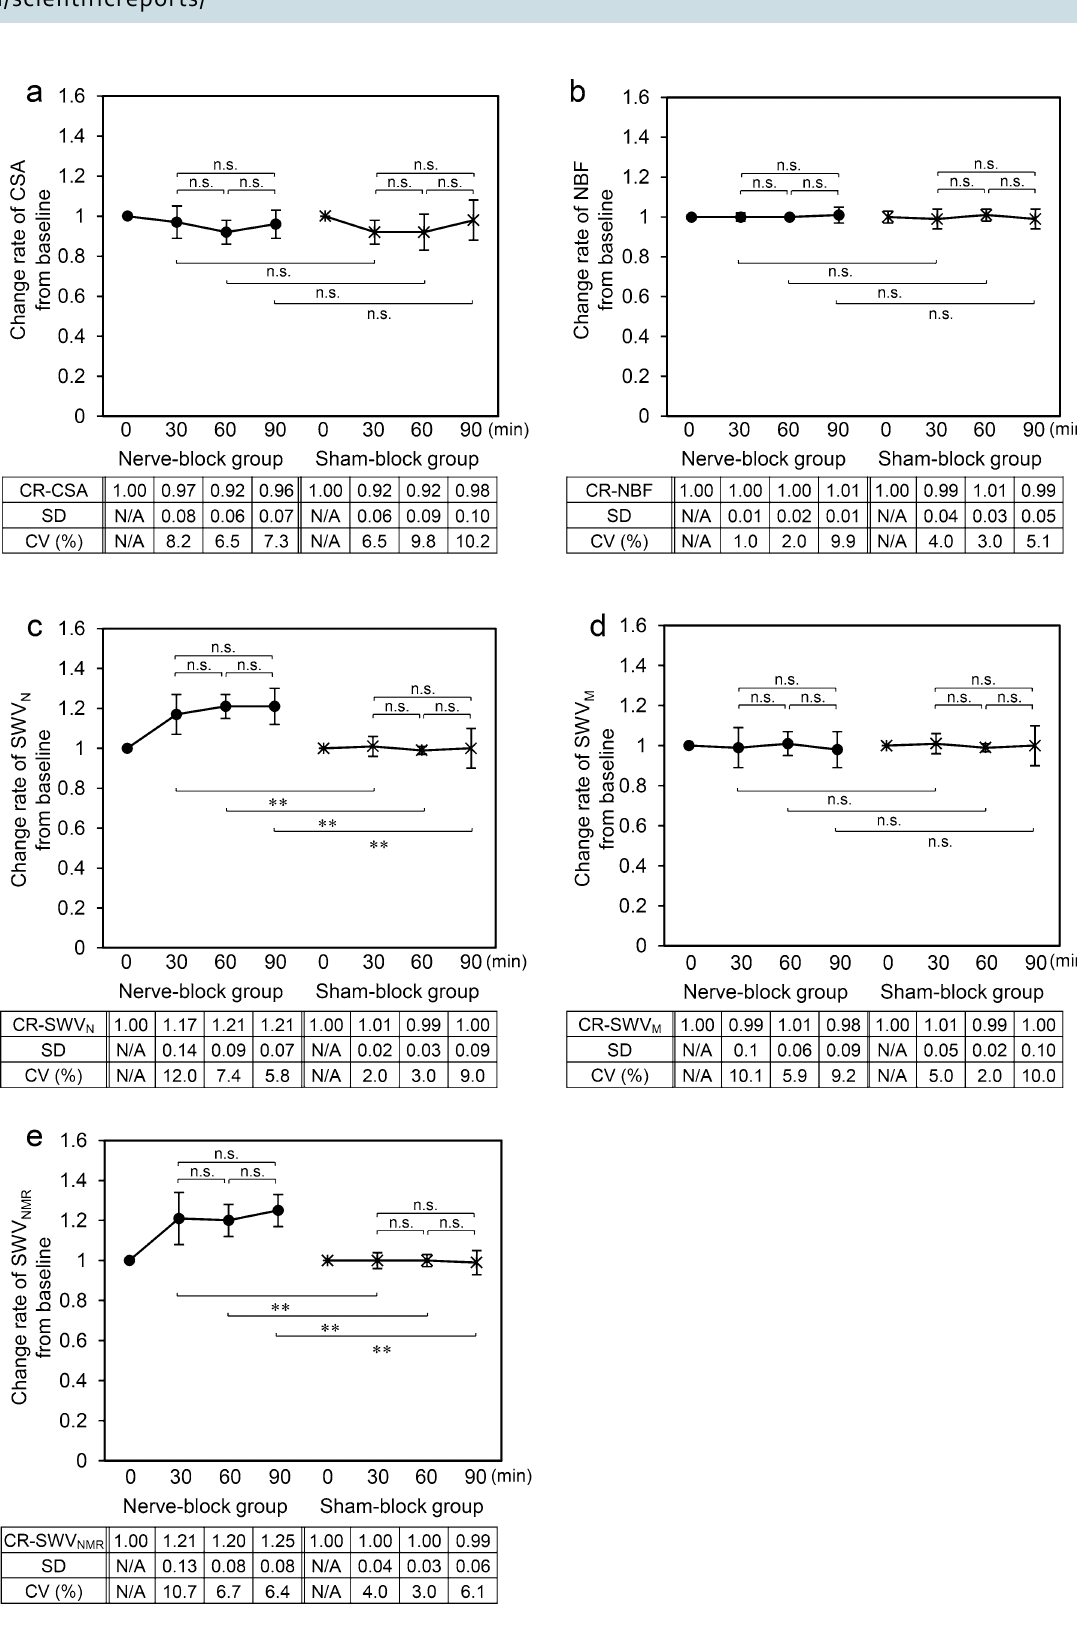
Figure 4. The change in the change rate of US parameters from the baseline value associated with the nerve block. ( a ) Change rate (CR) of cross-sectional area (CSA). ( b ) CR of nerve blood flow (NBF). ( c ) CR of shear wave velocity of the sciatic nerve (SWV N ). ( d ) CR of shear wave velocity of the muscle (SWV M ). ( e ) CR of the ratio of shear wave velocity of the nerve to muscle (SWV NMR ). SD standard deviation, CV coefficient variance, N/A not applicable. * p < 0.05, ** p <